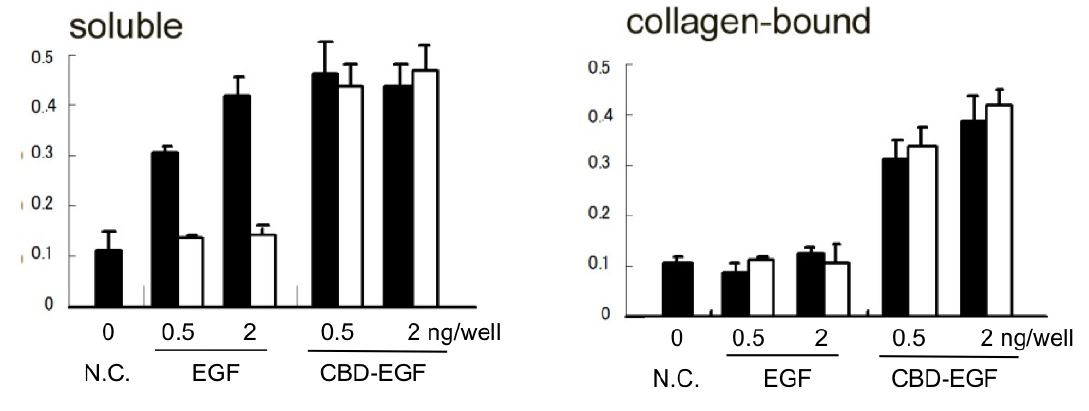
Figure 4. Stability of the growth-stimulating activity of collagen-binding epidermal growth factor (EGF). Fresh proteins or proteins stored at 4 °C for 30 days in culture medium (left graph) or bound to collagen-coated wells (right graph) were applied to cultures of human dermal fibroblasts (48-well plates). Filled columns, day 0; open columns, day 30. Cell growth activity was evaluated at seven days of culture using a WST1 colorimetric assay (absorbance at 450–650 nm; mean ± SD). Similar results were obtained for CBD-HGF (CBD = collagen-binding sites, HGF = hepatocyte growth